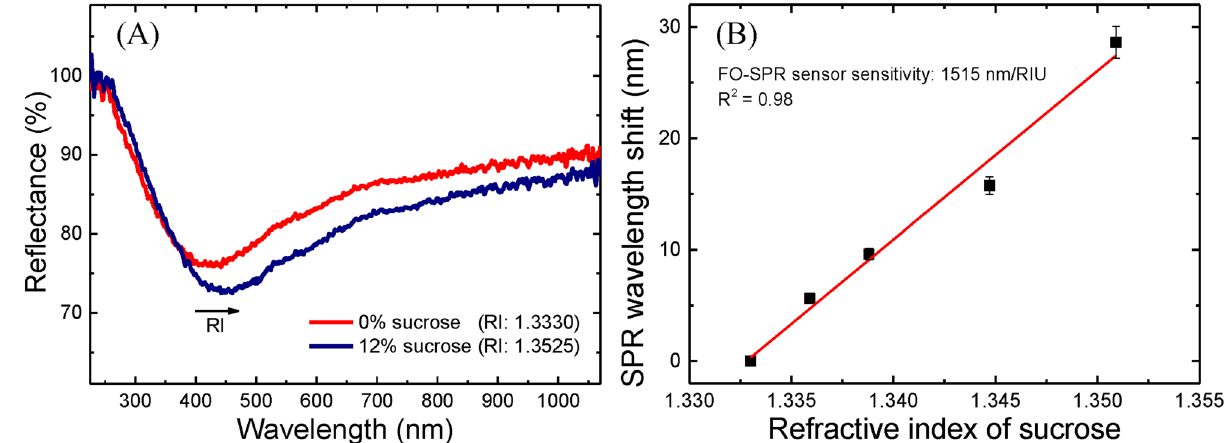
Figure 2. Evaluation of the Pt-coated FO-SPR sensors performance. ( A ) SPR spectral dips obtained at 0 (red) and 12% (blue) sucrose concentrations; ( B ) Corresponding calibration curve measured at sucrose concentrations (0, 2, 4, 8 and 12% w/w) with the Pt-coated FO-SPR sensors. The error bars represent standard deviation (n = 5) and R 2 denotes the coefficient of determination. Processed using Origin 9.6.0.172 (OriginLab 2019), https:// www. origi nlab. com/.